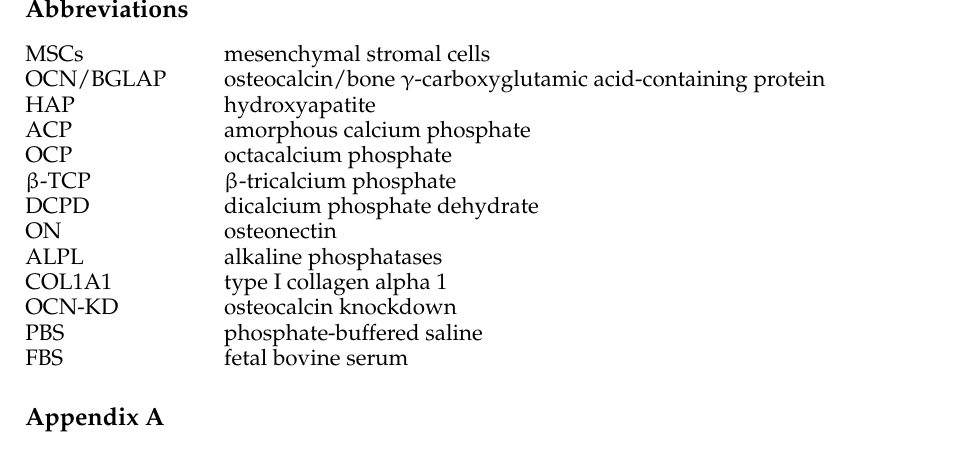
Table A1. Primer sequences and probes used for real-time PCR